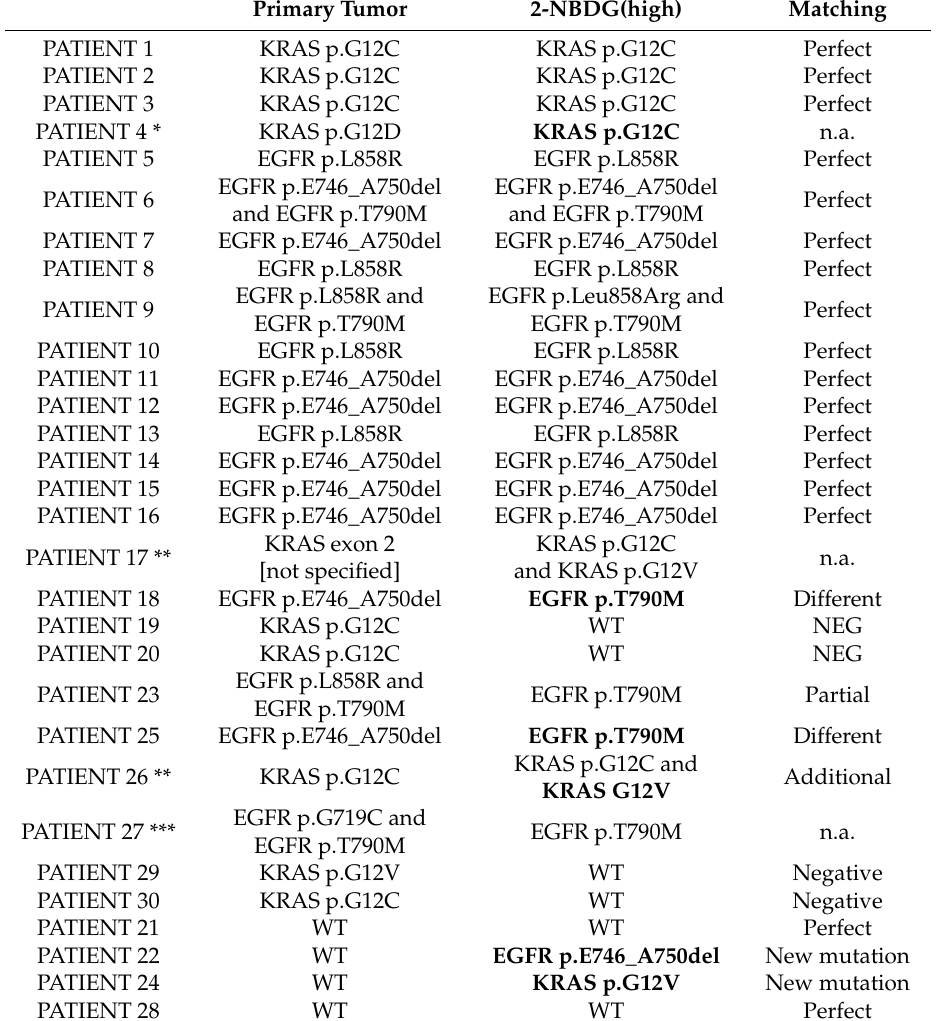
Table 3. Comparison between the mutations found in the primary tumor and in the 2-NBDG(high) sorted fraction. In bold, we highlighted the mutations detected in the cells that were different or additional with respect to those found in the primary